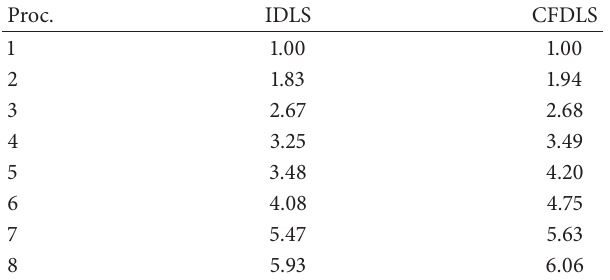
Table 4: Speed-up: 𝑁 (𝐵) with balanced start. Proc.